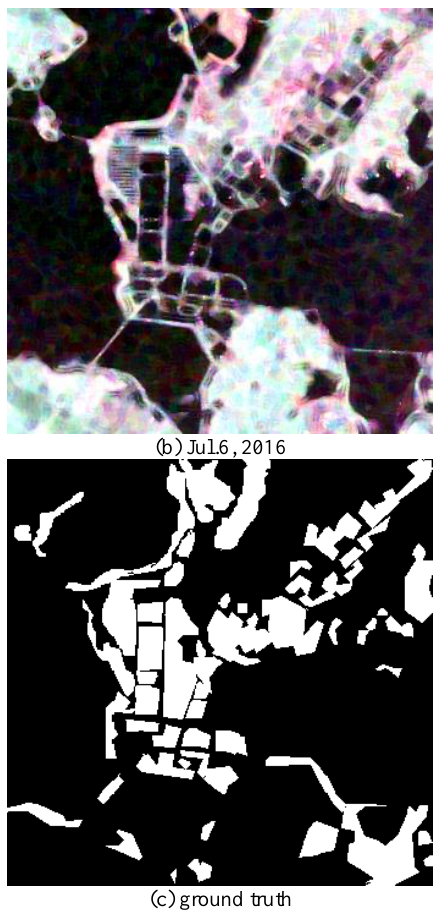
Figure 2. The Pauil-RGB images of datasets used in Figure 3. The Pauil-RGB images of YanDong Lake on (a) experiments: (a) Radarsat-2 SAR image acquired on June Jun.25, 2015; (b) Jul.6, 2016; (c) ground truth 25, 2015; (b) Radarsat-2 SAR image acquired on July 6, The bi-temporal PolSAR images shown in Figure 3 (a) (b) were 2016. acquired on Jun.25, 2015, and Jul.6, 2016, respectively. The image size is 400*400 pixels. The detailed assessments of area is located in YanDong Lake of Wuhan include some grassland, city and water bodies. The main changes occurred in the water area, because of continuing